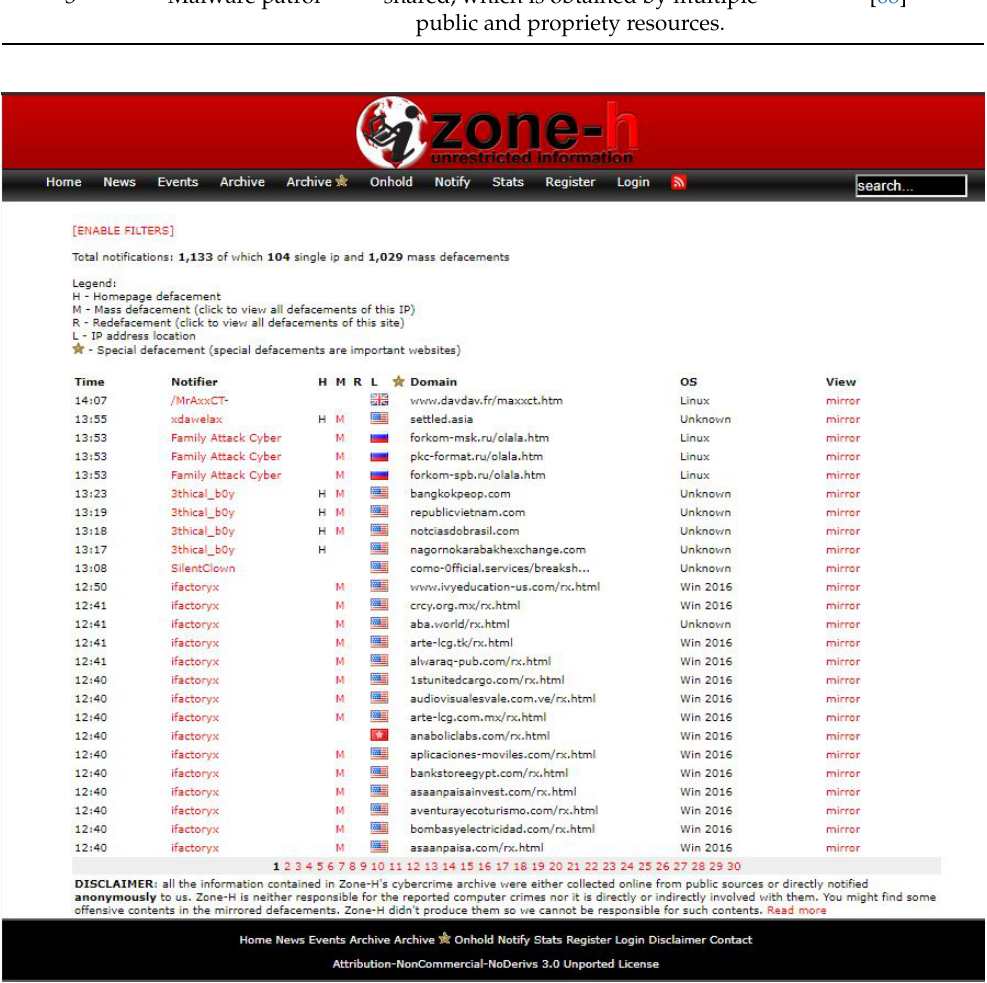
Figure 3. Website compromise disclosure